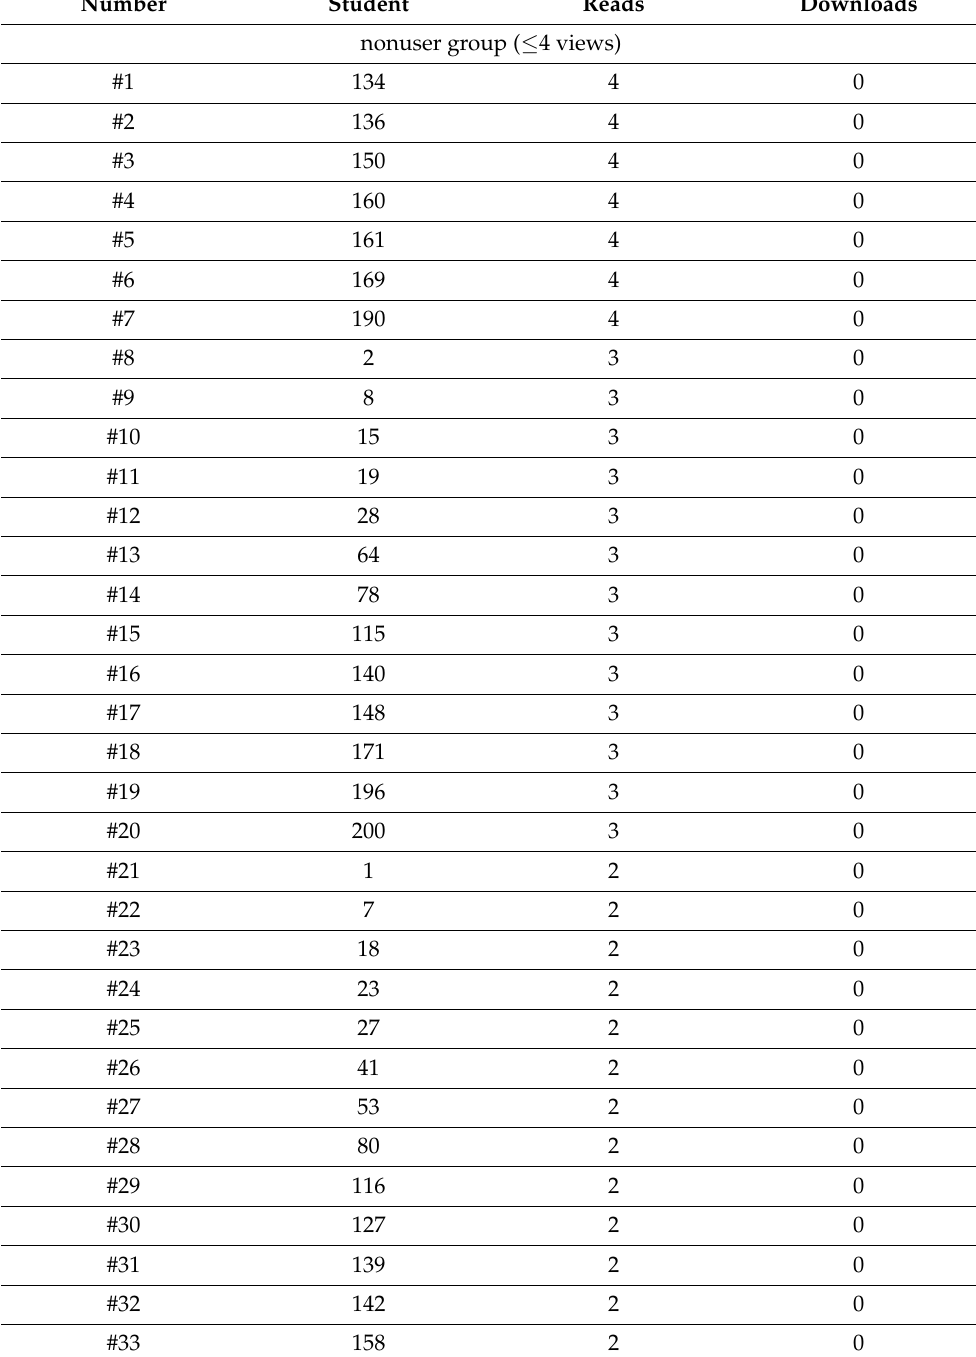
Table 3. Number of reads and downloads of the different user types during the pandemic study period. The number of reads and downloads during the 4-week pandemic study period is shown per individual user type. The definition of a user type is summarized above the respective